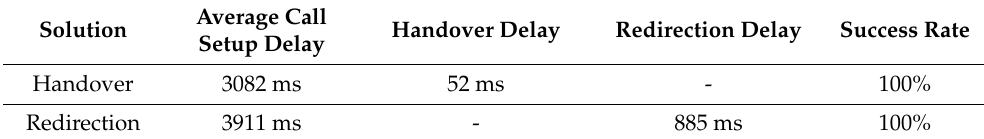
Table 3. EPS fallback call setup delay.